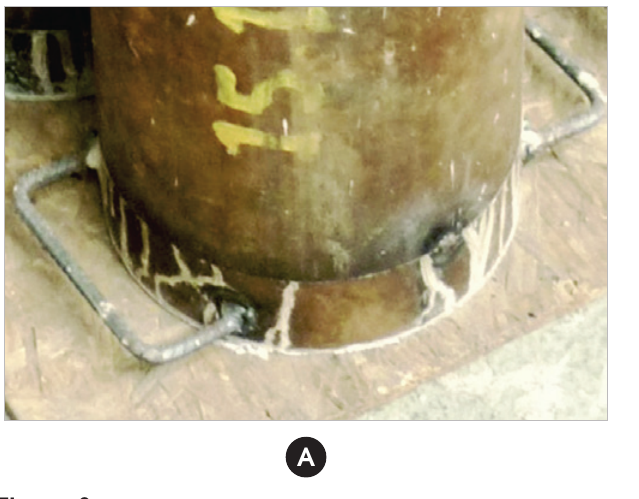
A B Details to obtain a gap of 50 mm in concrete